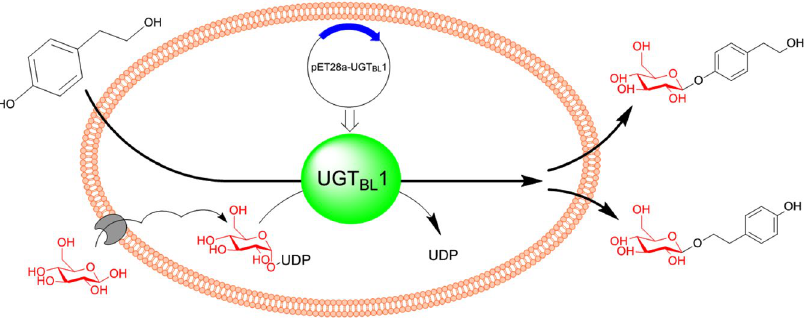
Figure 4. Scheme of synthesizing salidroside and icariside D2 by engineered E . coli harboring UDP- glycosyltransferase